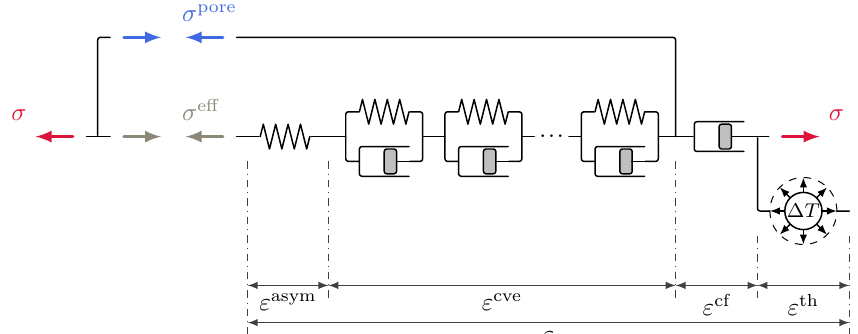
Figure 2. Schematic representation of the multiphase shrinkage and creep formulation in terms of the mixed stress concept; asymptotic elastic response and viscoelastic creep are driven by effective stress, viscous flow creep by total